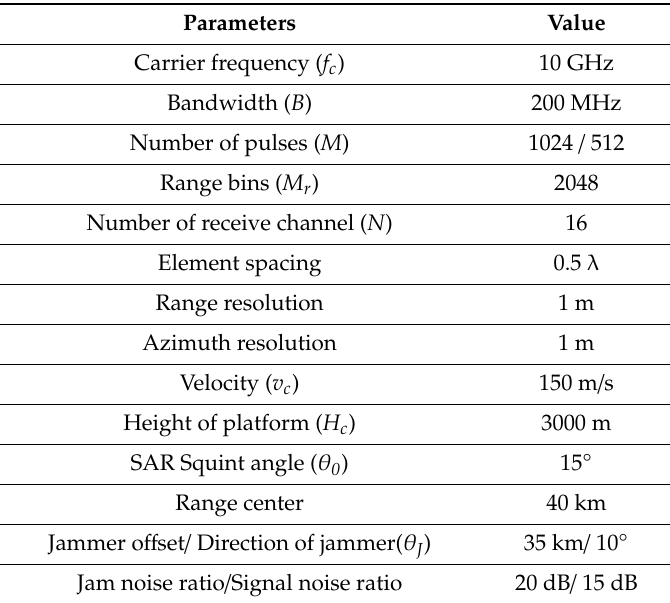
Figure 4. Simulation point targets.